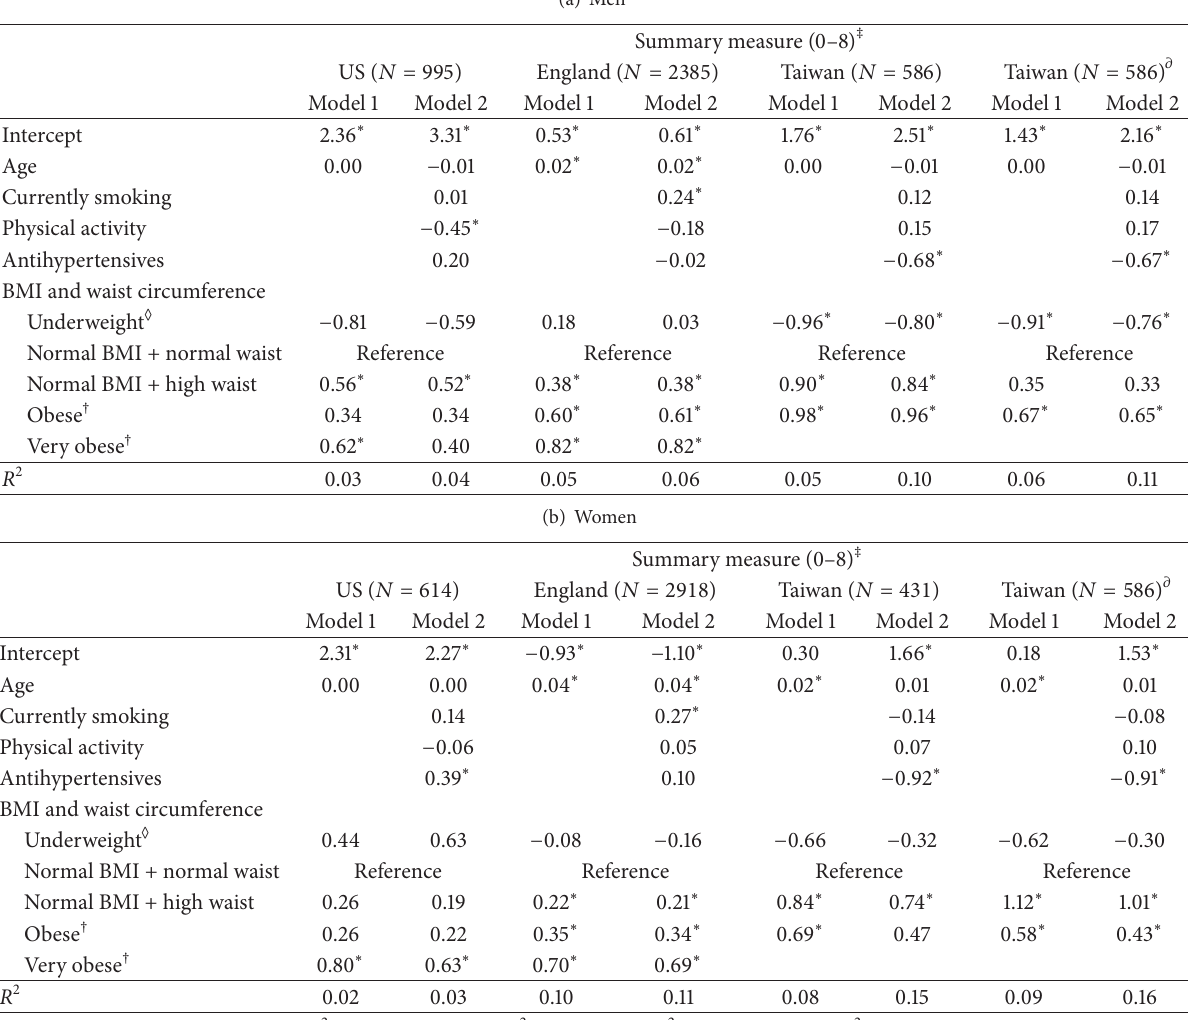
Table 5: Regression coefficients of the alternate summary measure (range: 0–8) ‡ of biological risk on body mass index (BMI) and waist circumference among older